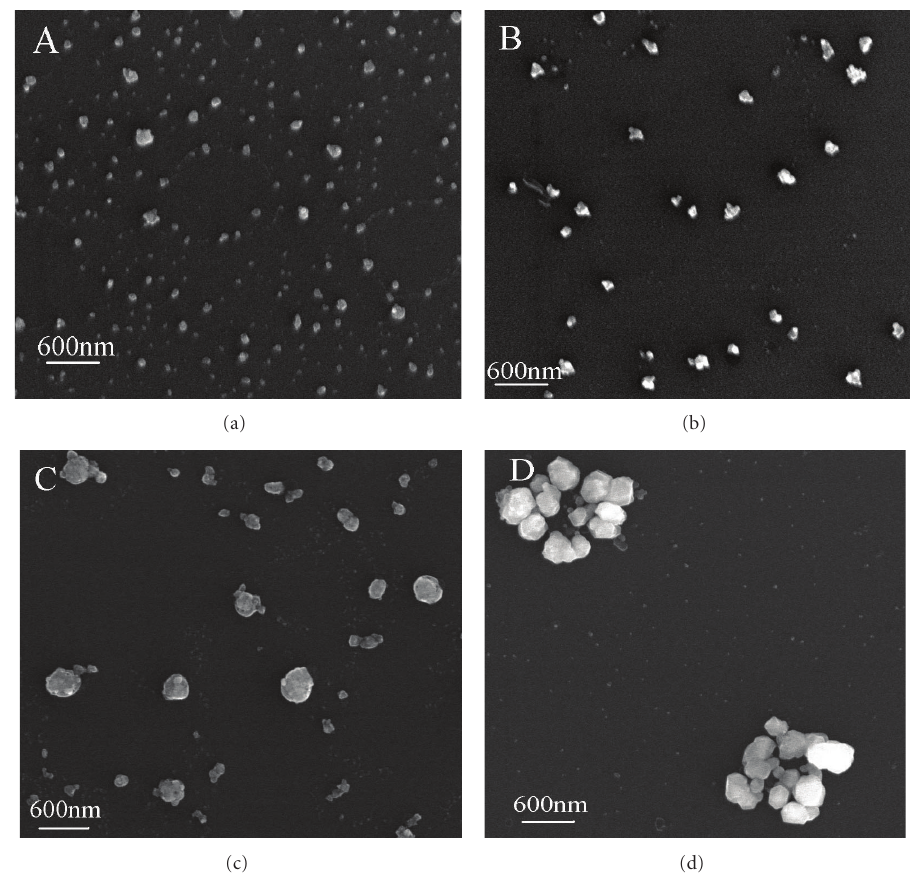
Figure 2: The scanning electron microscopy of AgNPs in the absence and presence of Hg (II) ion. Concentration: AgNPs: 6.5 × 10 − 5 mol/L; Hg (II) ion (from A to D, × 10 − 6 mol/L): 0, 2.0, 4.0, 6.0; HAc-NaAc bu ff er (pH 5.6).